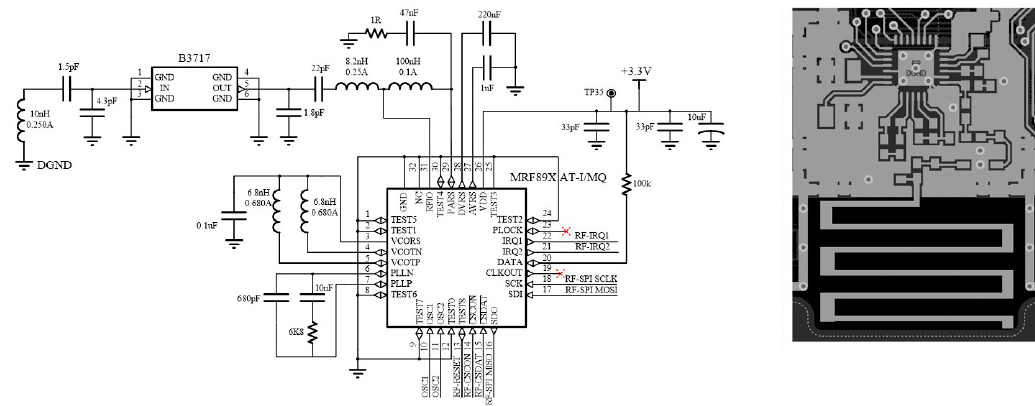
Figure 5. Designed antenna and scheme of the radio frequency (RF) module.